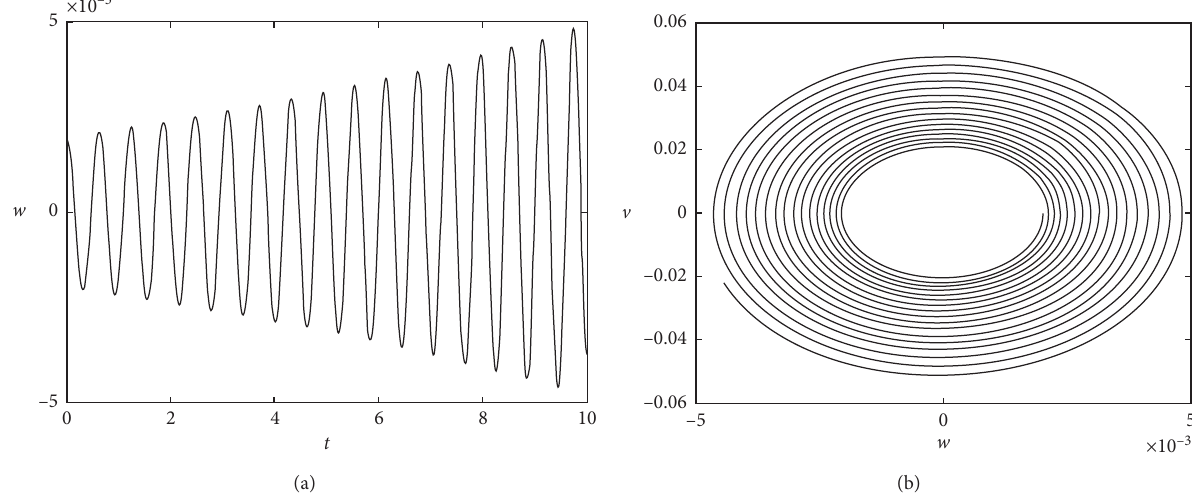
Figure 18: A divergent and unstable state of the system is kept in a critical state of stable and unstable when the inflow velocity U as 89m/s: (a) time history diagram of vibration amplitude on plane ( t , x